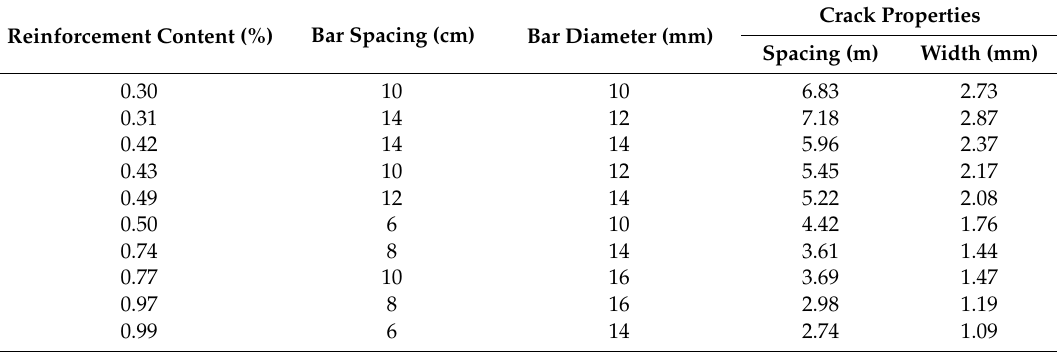
Figure 10. Impact of the reinforcement content of BFRP on the crack spacing ( left ) and crack width ( right ) of CRCP with BFRP bars. Table 5. The impact of s similar reinforcement content with di ff erent bar spacing and diameter on the crack behavior of CRCP with BFRP bars.